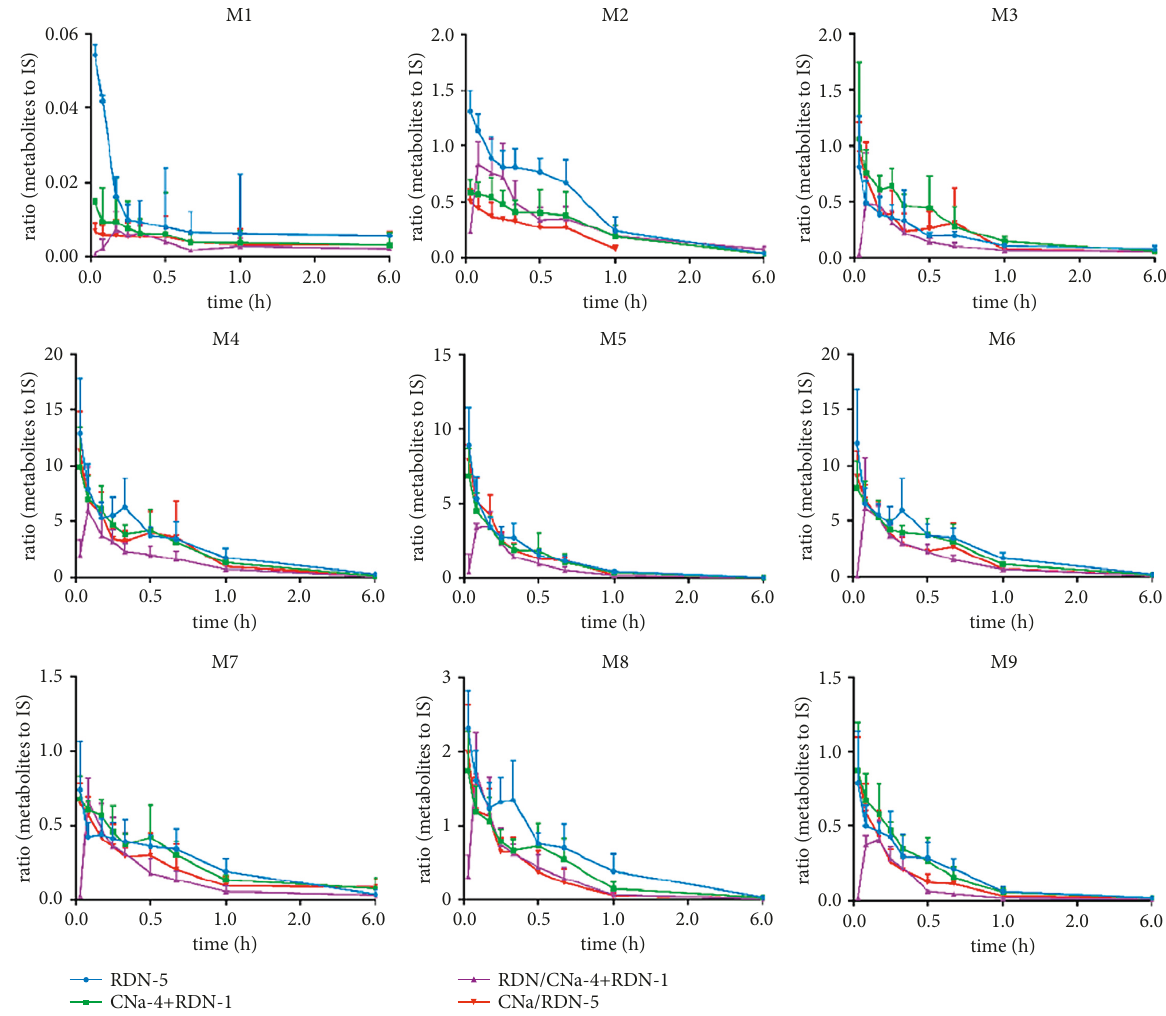
Figure 9: The curves of relative changes of the metabolites during 6 h after multiple